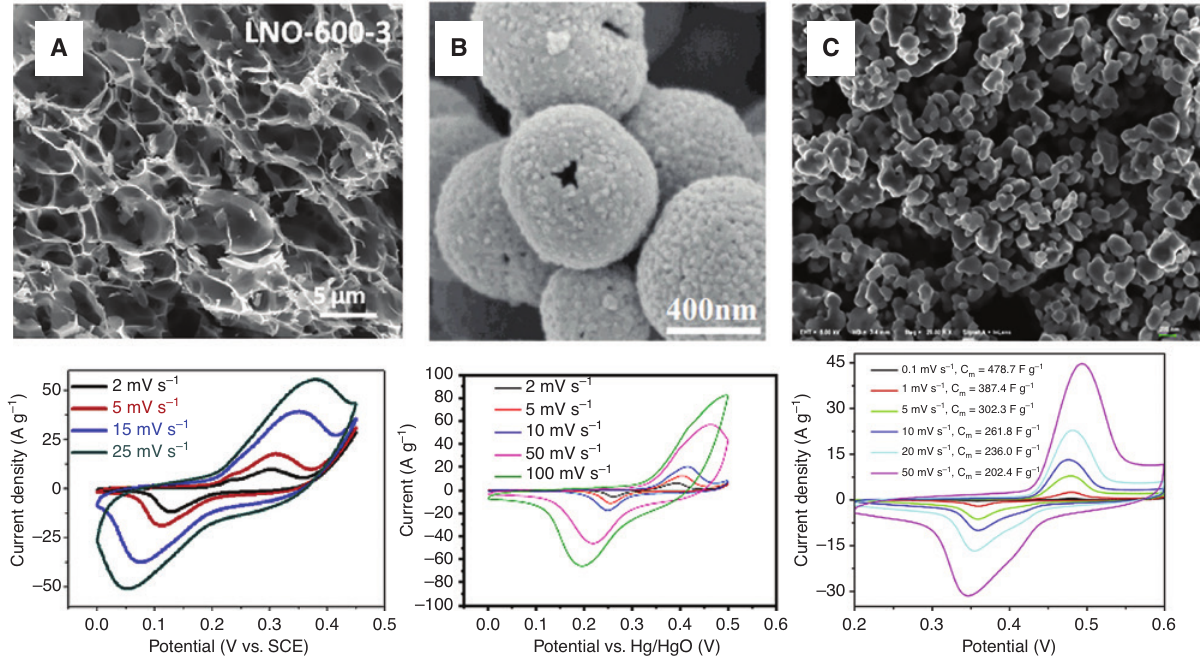
perovskite nanocrystals for electrodes in supercapacitors with morphologies; (A) nanosheets, (B) hollow nanospheres, Figure 10: LaNiO 3 (C) irregular-shaped nanocrystals (above figures) and their cyclic voltammetry measurements at different scan rates (below figures). (A) Reproduced with permission from ref [49]. Copyright 2017, Elsevier. (B) Reproduced with permission from ref [48]. Copyright 2017, Elsevier. (C) Reproduced with permission from ref [261]. Copyright 2018,